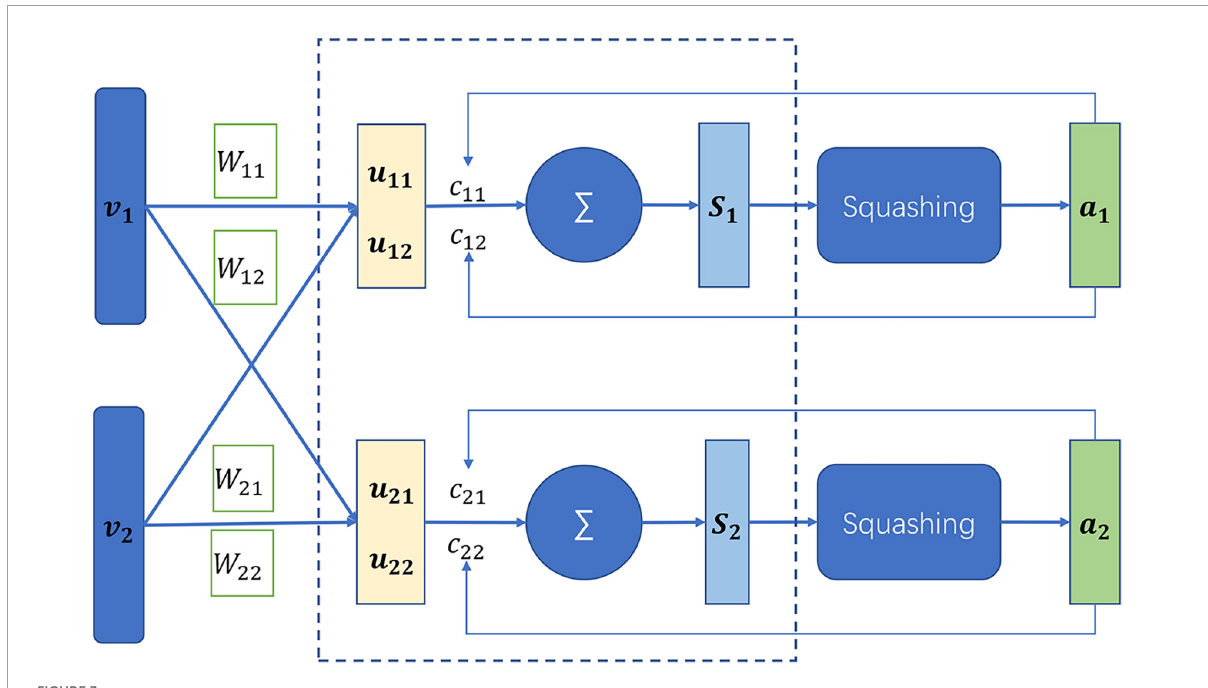
FIGURE3 Illustration of dynamic routing in the capsule network (Lee, 2018).